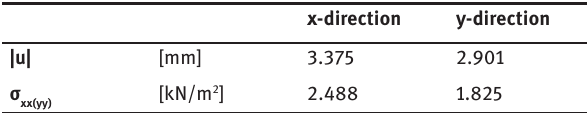
Table 9: Normalized Deviation (with respect to average) of σ